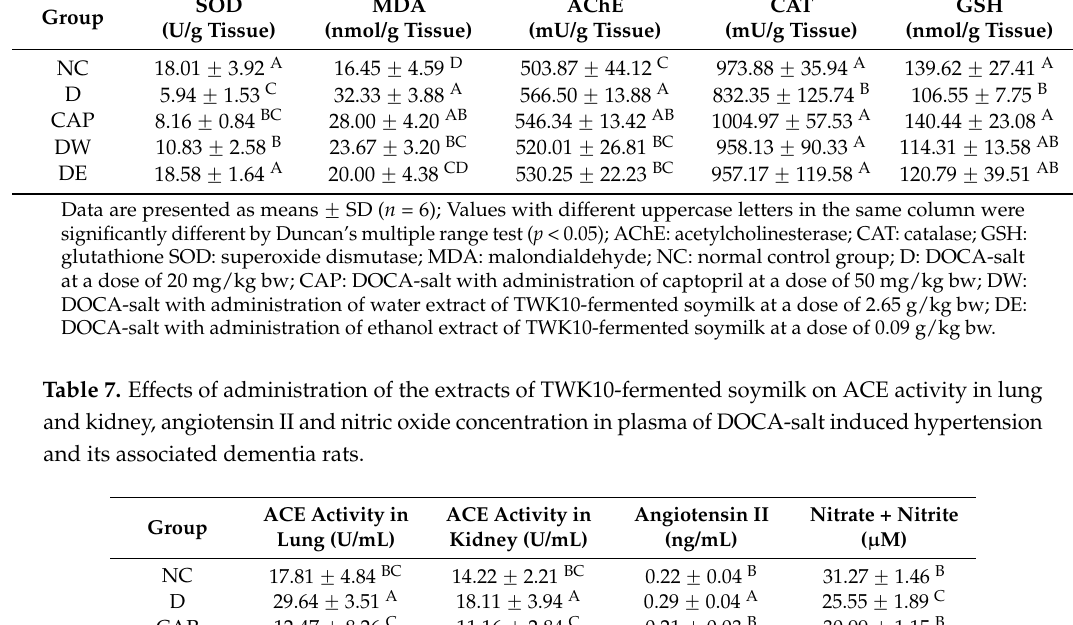
Table 6. Effect of administration of the extracts of TWK10-fermented soymilk on superoxide dismutase, acetylcholinesterase, catalase activities and malondialdehyde, glutathione concentration in brain of DOCA-salt hypertension induced vascular dementia rats. Group